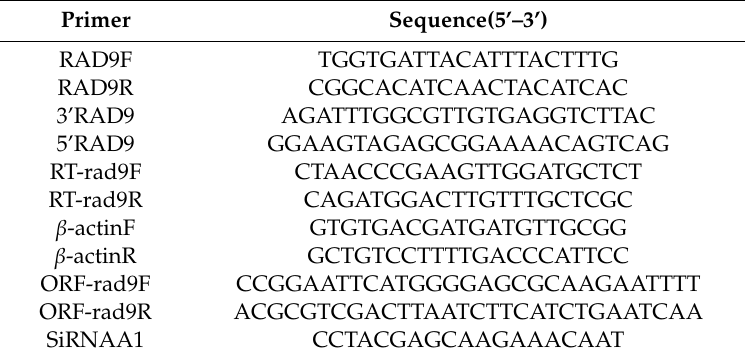
Table 2. Oligonucleotide primers used in this